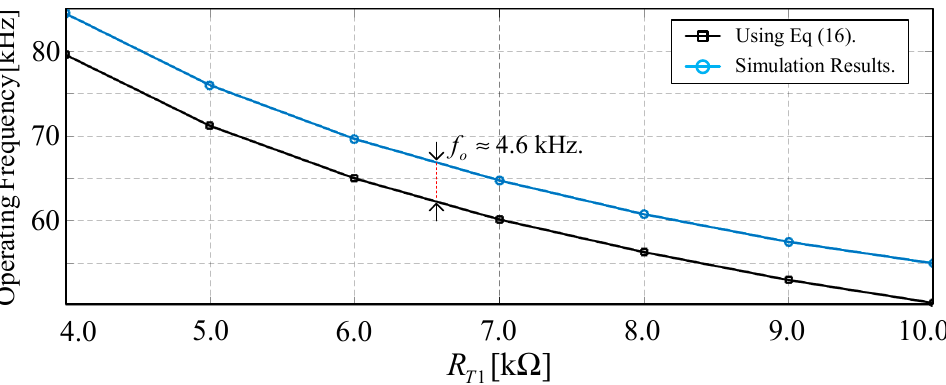
Figure 12. Switching frequency of the converter using Equation (16) and simulation based on the new feedback for the charger side.